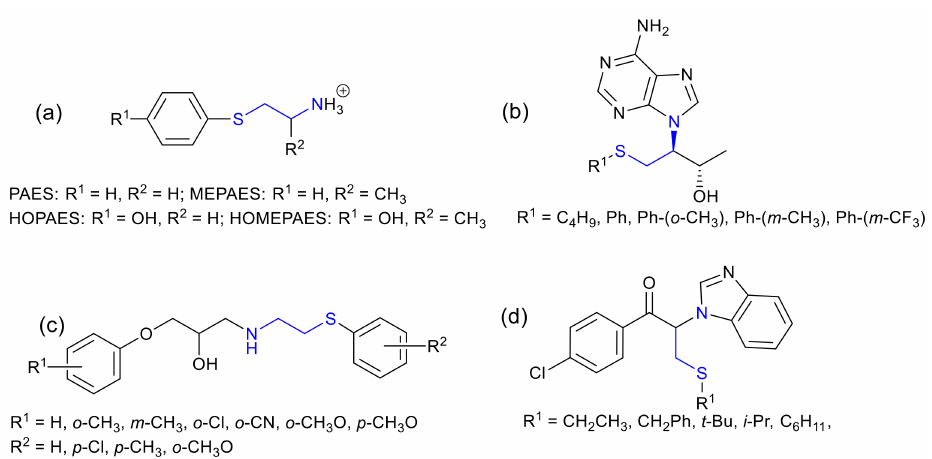
Figure 1. Literature examples of aminoethyl sulfides with biological properties. ( a ) PAES, or struc- turally similar derivatives; ( b – d ) compounds containing an aminoethyl sul-fide